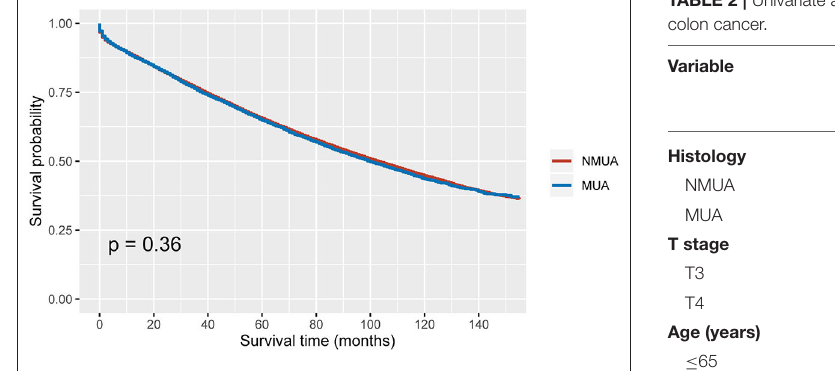
chemotherapy in stage II colon cancer (HR = 0.622, 95% CI = 0.597-0.648, P < 0.001).